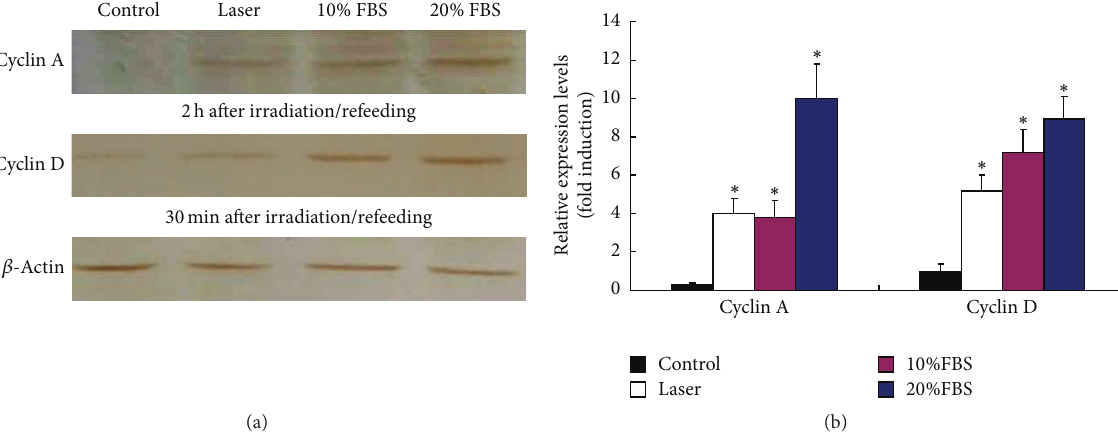
Figure 4: Western blot analysis of cyclin D and cyclin A protein expression after irradiation/refeeding (a). The expression levels of cyclin D and cyclin A were subsequently measured by densitometric analysis (b). The relative protein expression values were normalized to that of 𝛽 -actin. ∗ 𝑃 < 0.05 compared with nontreated